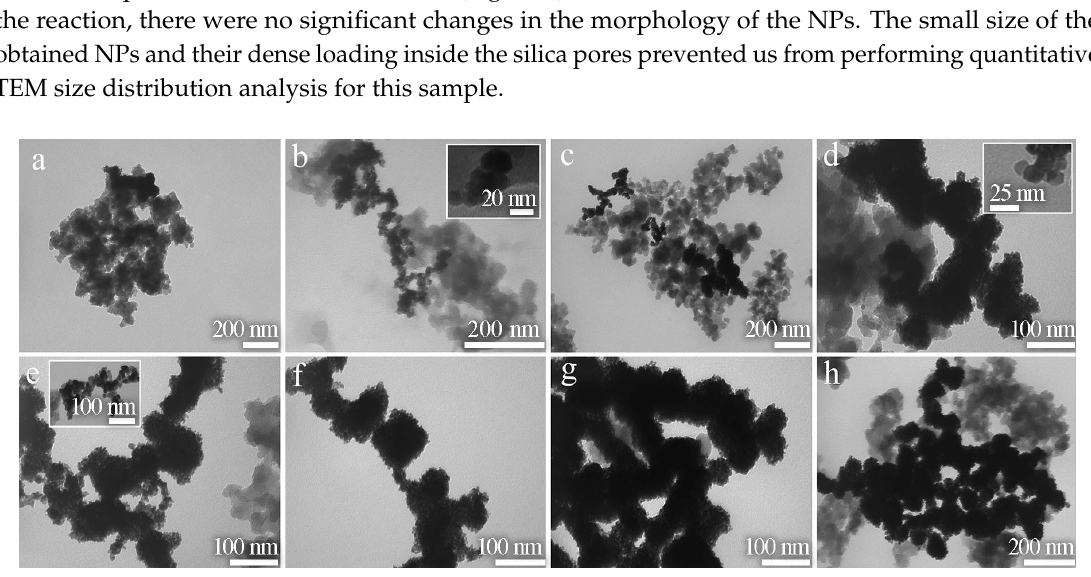
Figure 2. Representative TEM micrographs for Pd/SiO 2 samples reduced by polyethylene glycol (PEG) at different time intervals after reaching 180 °C: ( a ) 0 min; ( b ) 15 min; ( c ) 30 min; ( d ) 45